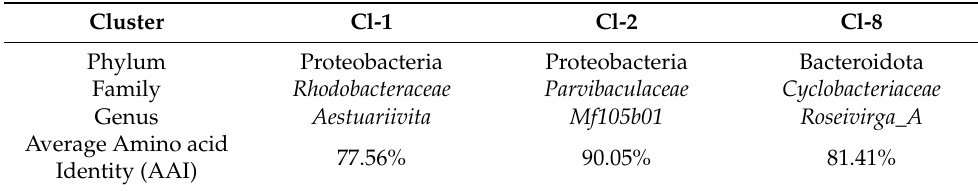
Table 3. Selected MAG phylogeny.